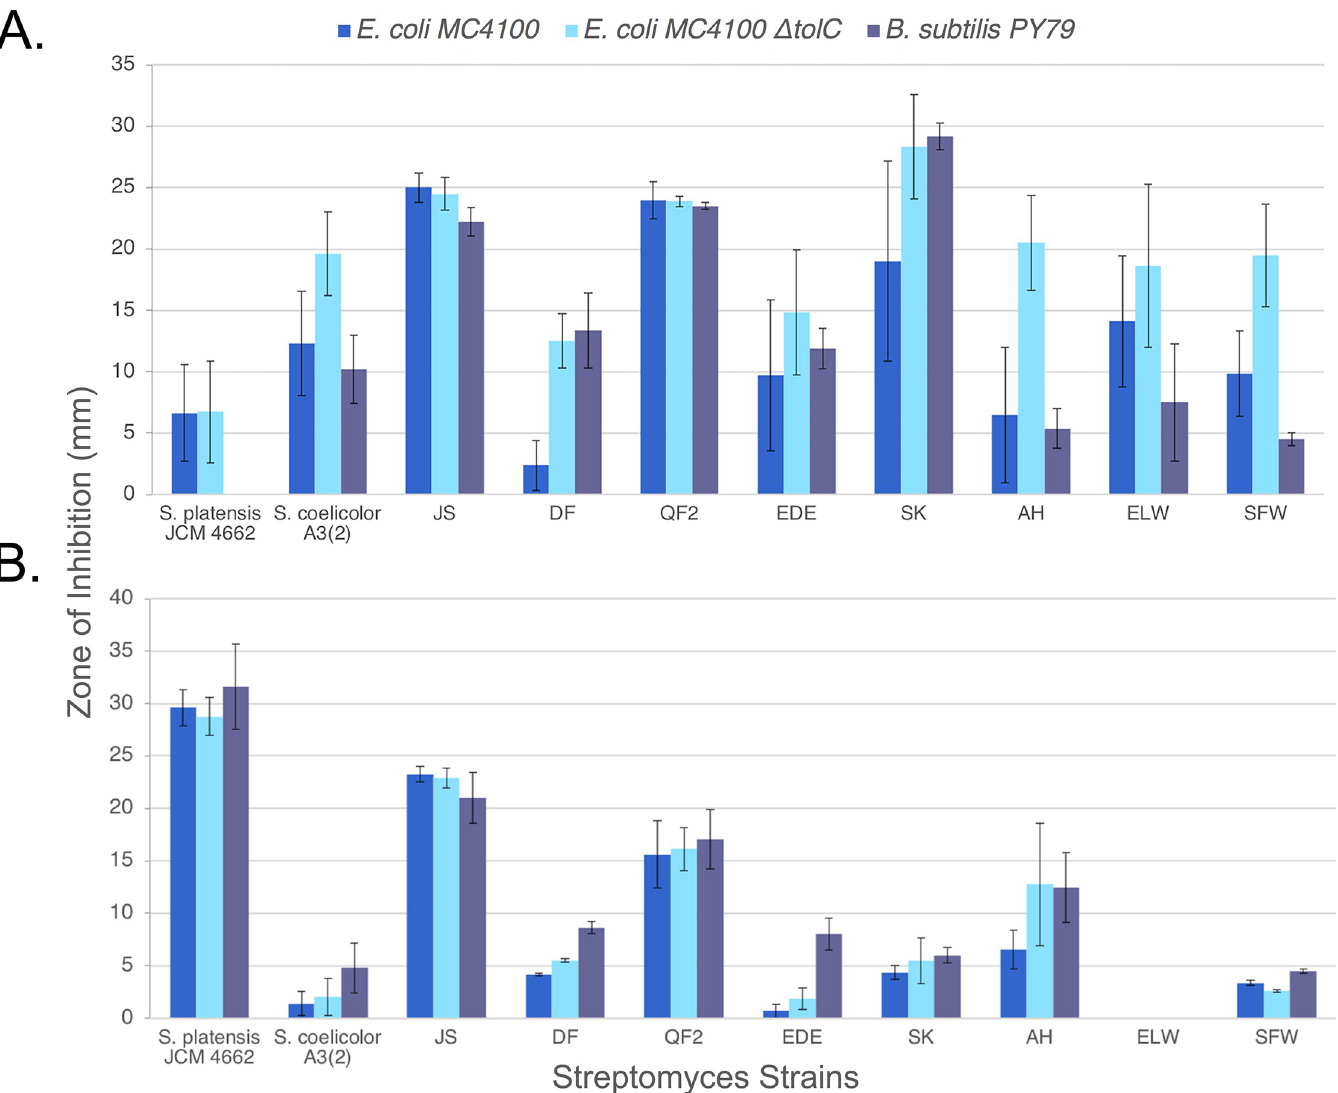
Fig 2. Inhibition of bacterial growth by Streptomyces isolates. The cross-streak method was used to measure the zone of inhibition among ten Streptomyces strains against two Gram-negative E . coli strains (MC4100 WT, JP313 Δ tolC ), and one Gram-positive strain B . subtilis PY79 on ( A ) LB and ( B ) AIA. Error bars represent the standard deviation of three independent